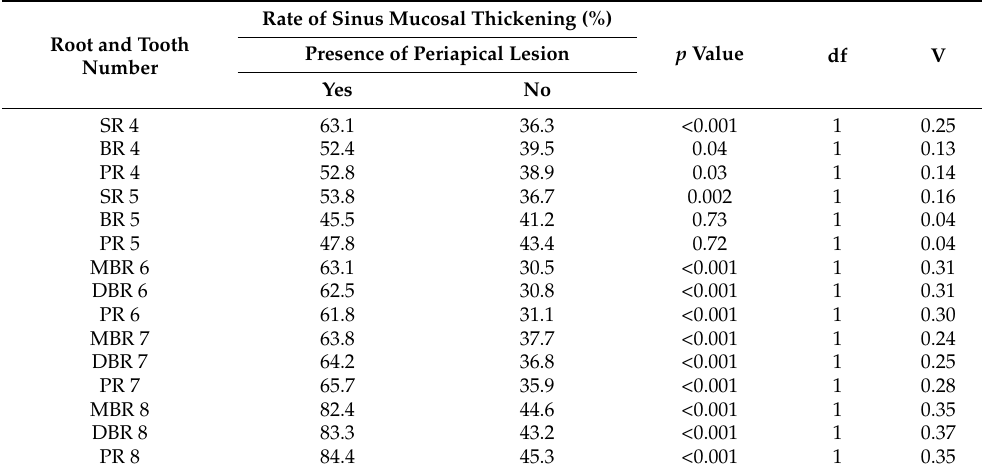
Table 3. The effect of the presence or absence of periapical lesions around the different tooth roots on the rate of sinus mucosal